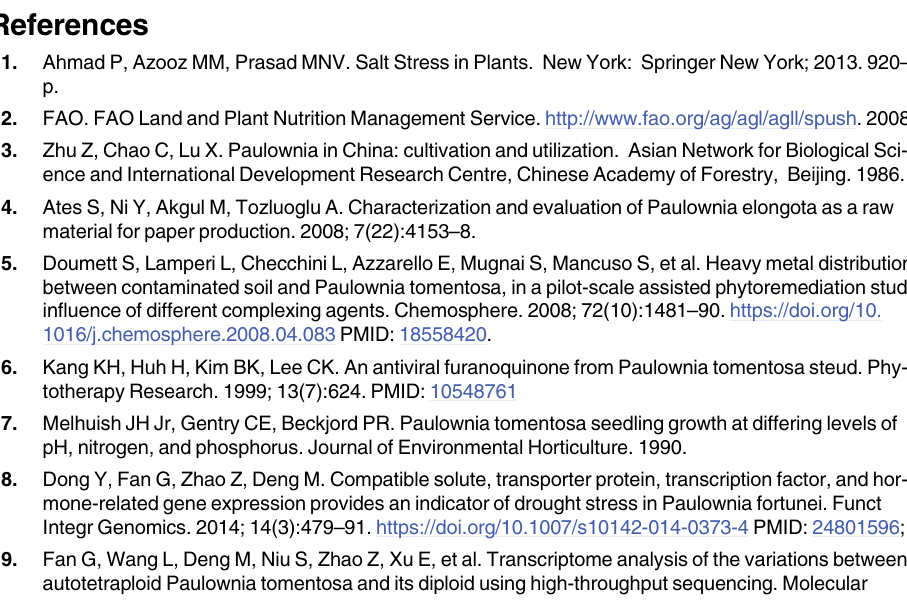
S8 Table. The photosynthesis of DEGs in the comparisons schemes: Comparison A, com- parison B, comparison C, and comparison